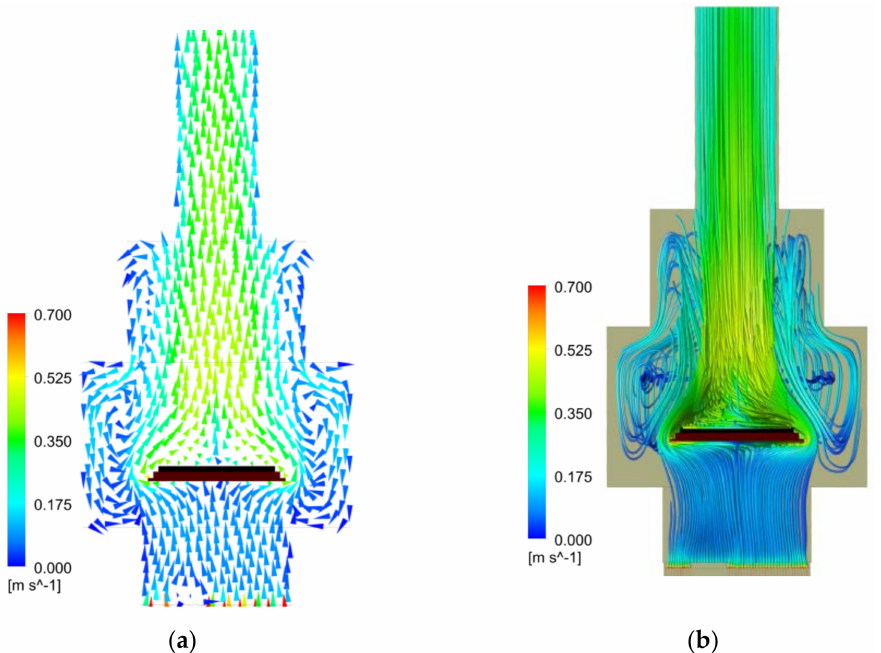
Figure 5. The velocity field, in the form of ( a ) vectors and ( b ) streamlines in the reactor cross-section, obtained at the pressure of 0.5